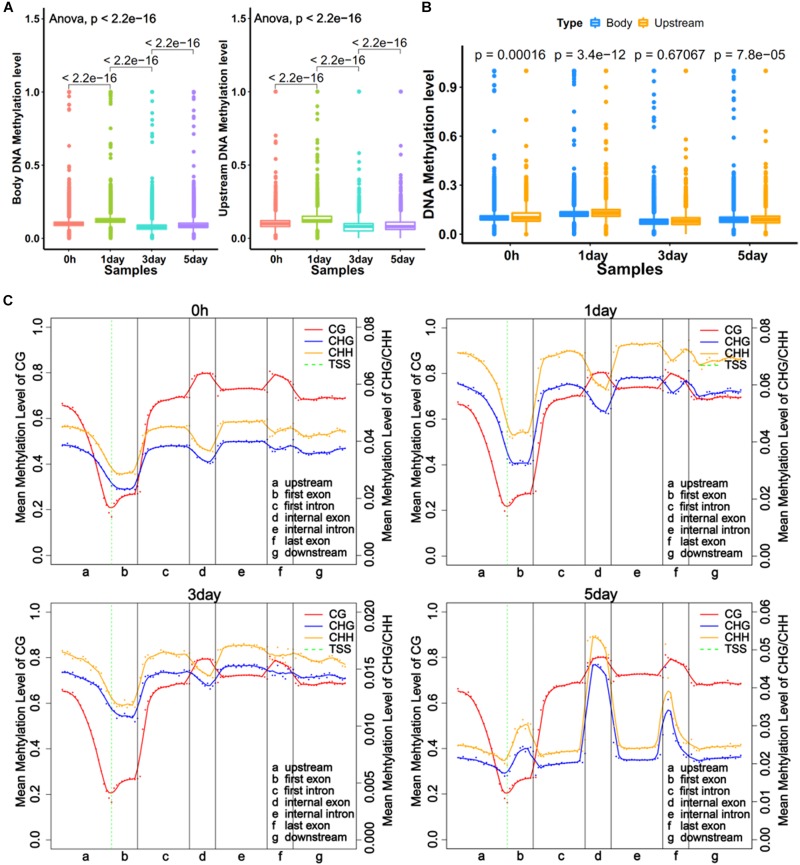
Global trends of DNA methylomes in different gene regions. (A) Average methylation level of different samples within upstream and gene bodies. The boxes in Graphs A and B represent quartiles, while whiskers represent minimum and maximum values. (B) DNA methylation level between upstream and gene body regions. (C) Average methylation levels throughout different gene regions in four samples. The entire gene was divided into seven different regions, denoted by the x-axis. The length of each transcription element region was an equal number of bins. Each dot shows the average methylation level of the bin; the full lines show the mean methylation level of five-bins. The green dotted line between Graphs A and B is TSS (transcription start site) position. Left y-axis indicates mean methylation level (0–1) of CG, right y-axis indicates methylation level of CHG or CHH.